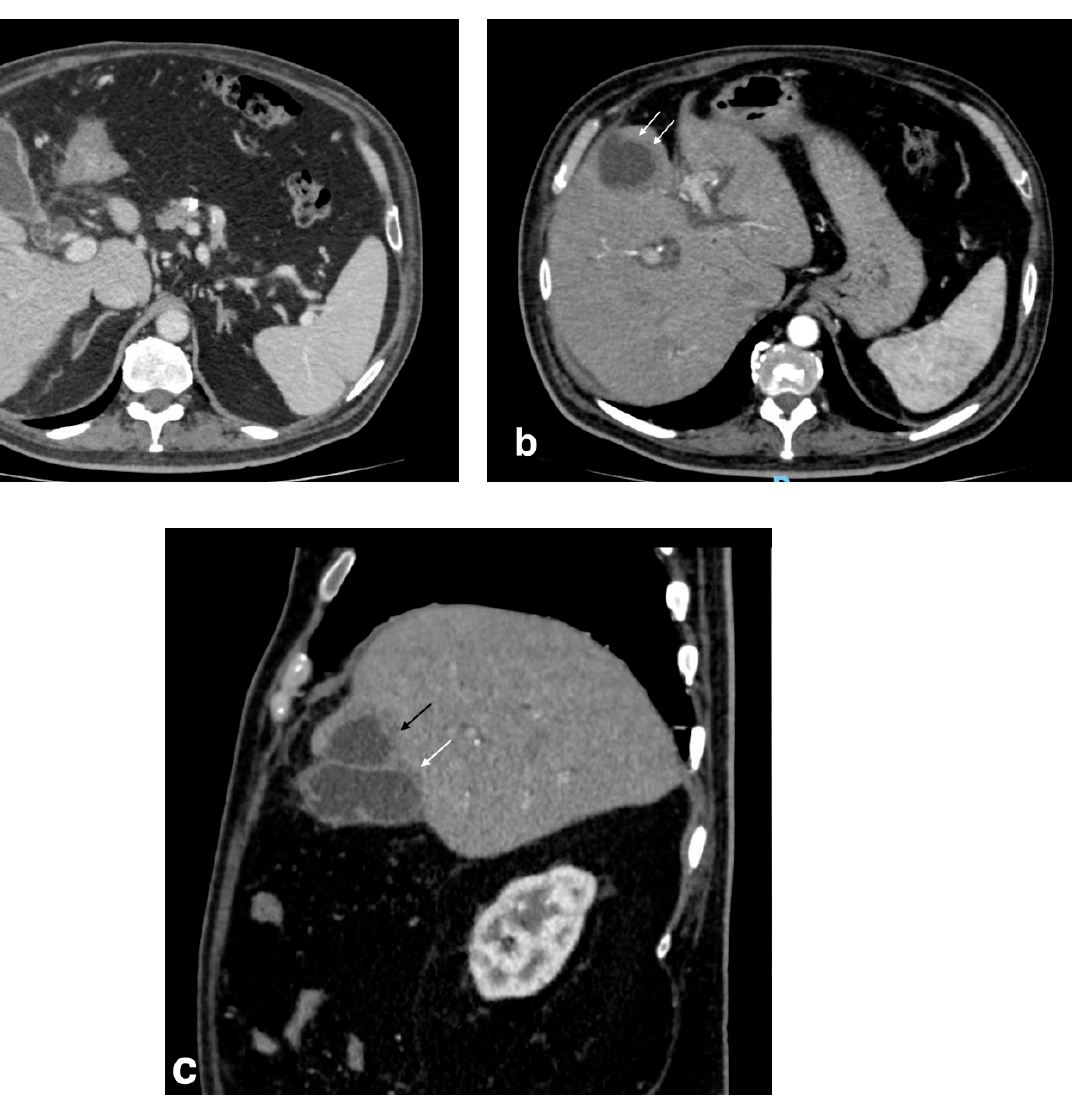
Figure 8. Pericholecystic abscess: ( a ) axial images show acute cholecystitis findings with wall thickening and hyperdensity; ( b ) a hypoattenuated sovracholecistic collection (white arrows) due to hepatic pericholecystic abscess; ( c ) sagittal image evidences the proximity of the two structures (abscess: black arrow; cholecyst: white arrow).